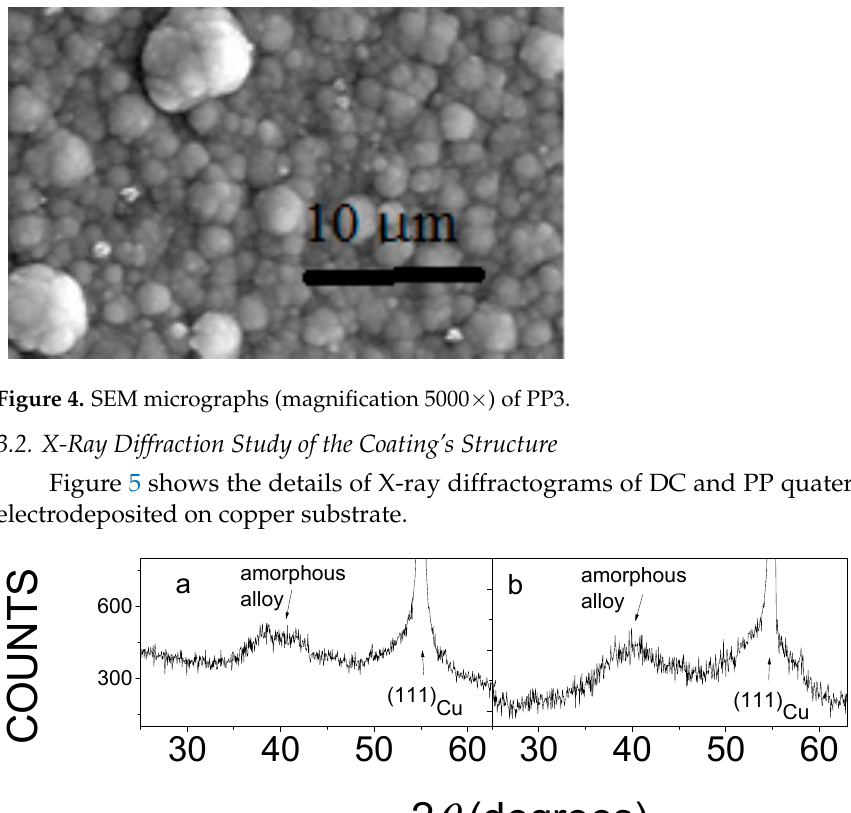
Figure 5. Details of XRD patterns of the DC3 ( a ) and PP3 ( b ) electrodeposited quaternary Sn-Fe-Ni- Co alloys.